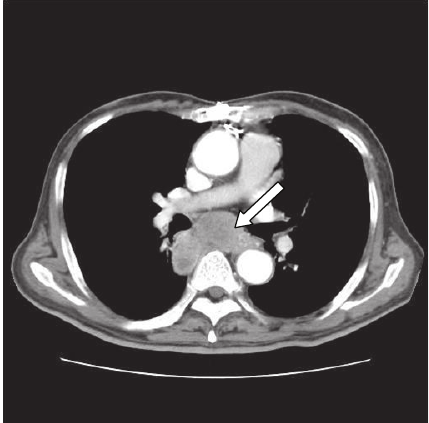
Figure 3: Chest computed tomography scan shows the multiple metastatic lymph nodes enlargement at subcarinal area (white